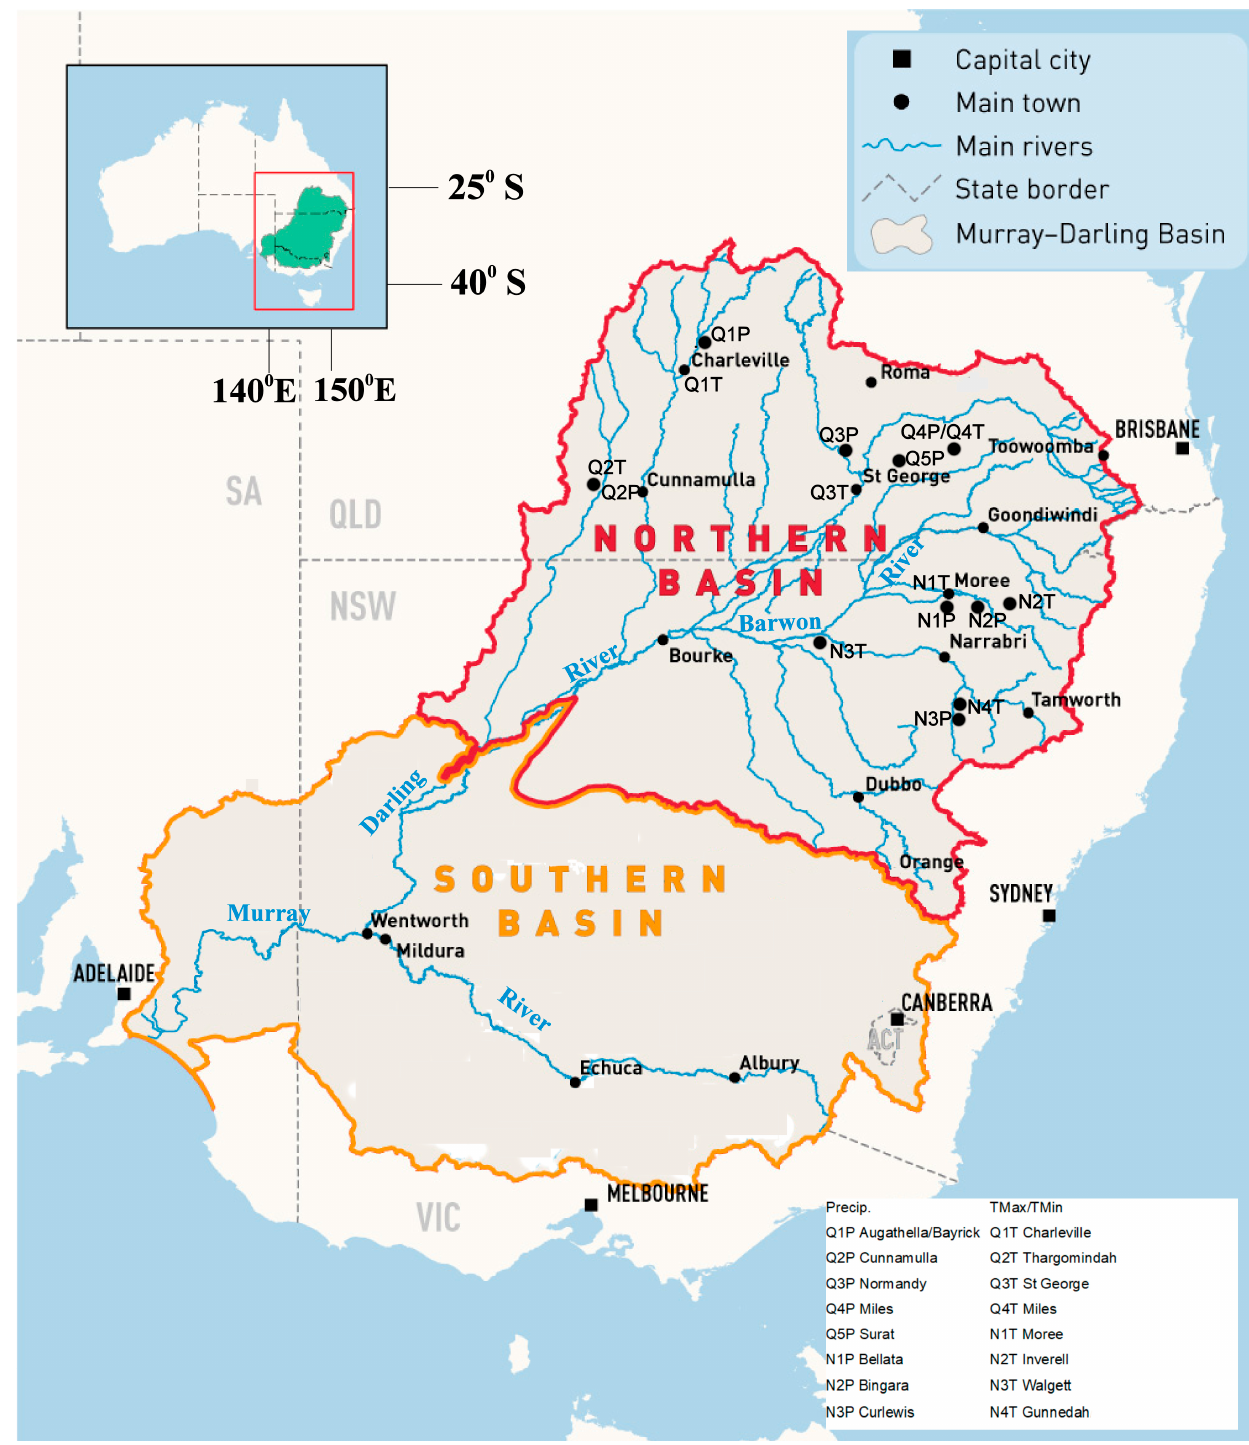
Figure 1. Map of northern and southern Murray-Darling Basin in southeast Australia . The MDB lies within subtropical latitudes (25° S–38° S) of the Australian continent. Observation stations used for precipitation, TMax and TMin averaging that represent the NMDB are marked and indicated in a legend. (Source: Murray-Darling Basin Authority, G.P.O. Box 1801, Canberra City, ACT 2601 Aus- tralia. https://www.mdba.gov.au/sites/default/files/pubs/Murray-Darling_Basin_Boundary.pdf (accessed 19 August 2022)). Reproduced with some place name deletions and insertions via license: BY-NC-ND